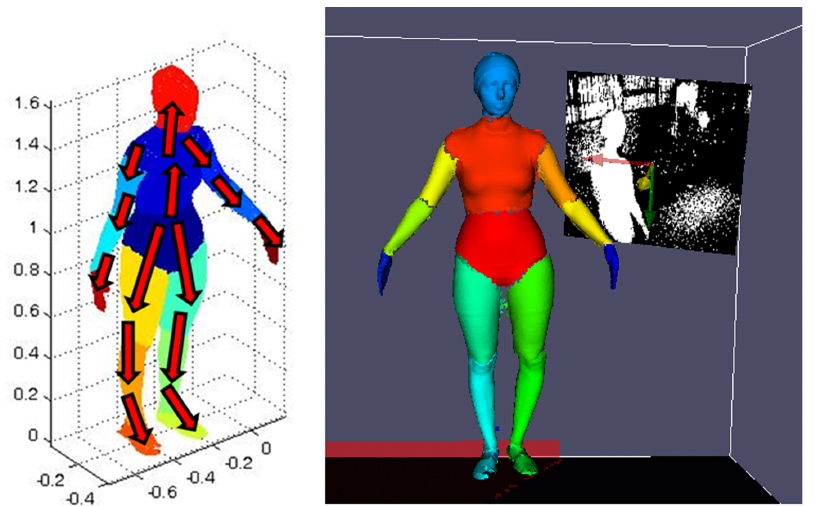
Figure 3. From left to right: tracking of the model as obtained from a static trial; scheme of the model kinematic tree (each arrow point from ‘‘parent’’ segment to ‘‘child’’ segment).